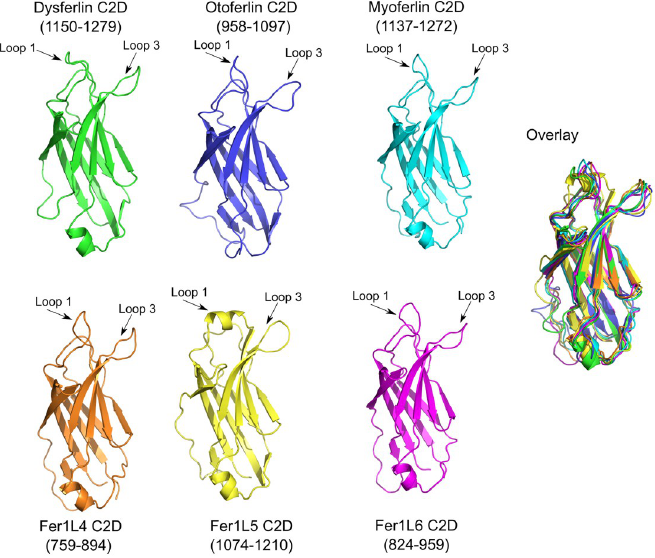
Fig 9. C2D models for dysferlin C2D (green), otoferlin C2D (blue), myoferlin C2D (cyan), Fer1L3 C2D (orange), Fer1L5 C2D (yellow), Fer1L6 C2D (magenta). The superposition of all six C2D models is labeled as ‘Overlay’.